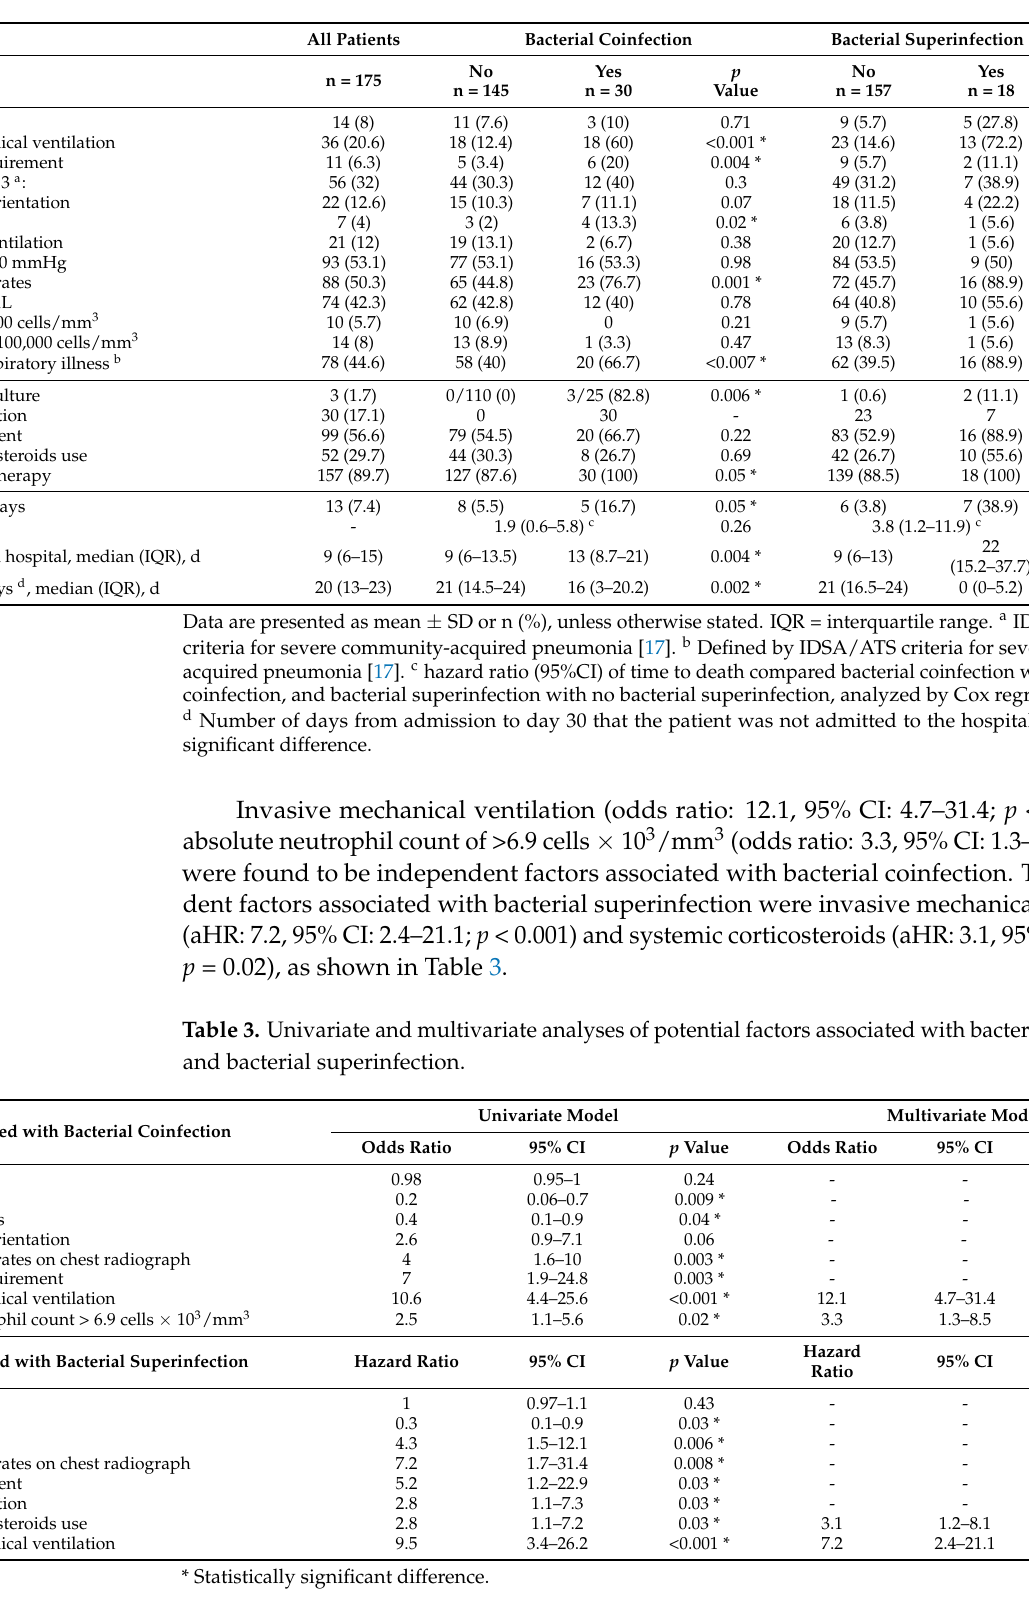
Table 2. Severity at admission, treatment, and associated bacterial coinfection and bacterial superin- fection of all patients hospitalized with respiratory syncytial virus-associated acute respiratory illness.